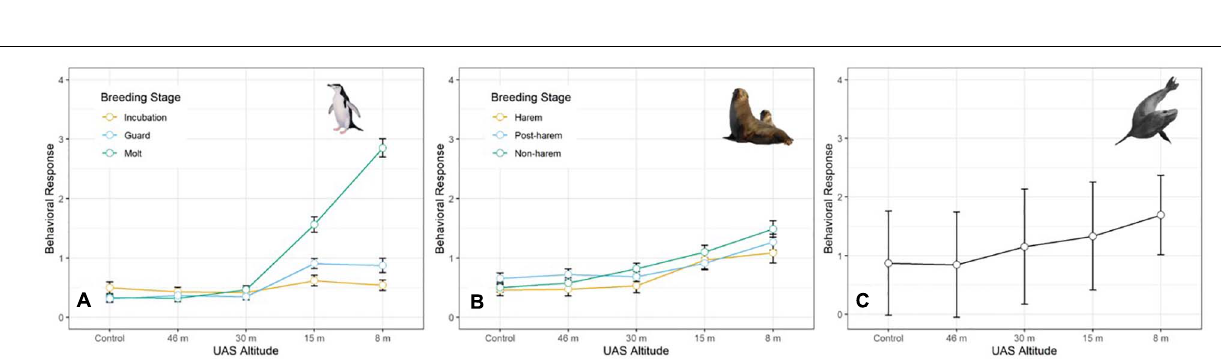
FIGURE 4 | Average behavioral responses (plotted with standard deviation error bars) (A) of adult chinstrap penguins (CHPE, n = 1212 scores), (B) Antarctic fur seals (AFS, n = 480 scores) and (C) leopard seals (LS, n = 234 scores) to UAS overflights at 30 m versus ground-based surveys. The behavioral reaction of LS to ground-based capture/measurement was “escape” (level 4) 100% of the time.